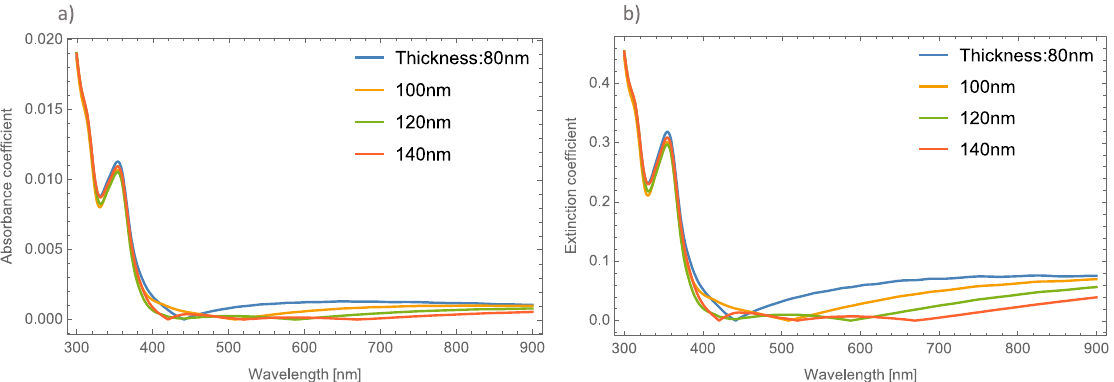
Figure 2. ( a ) Absorbance coefficient for different thicknesses of the MoO 3 thin film without resonant NPs. ( b ) Extinction coefficient for different thicknesses of the un ‐ doped MoO 3 thin film.